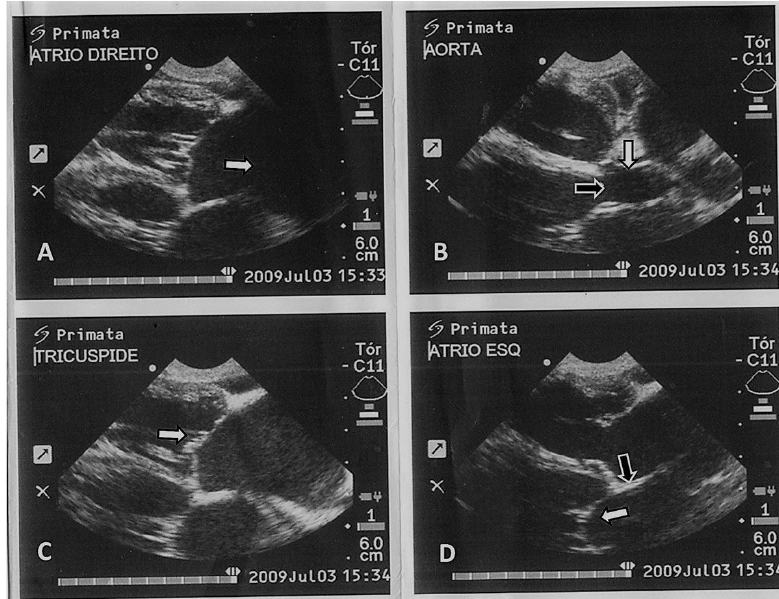
Figure 2. Echocardiographic examination. (A) Enhanced right atrium (filled arrow); (B) Aorta unchanged: preserved aortic valve (arrow outline) and intact aortic entry (filled arrow); (C) Discrete reflux in tricuspid, evaluated by Doppler (filled arrow); (D) Left atrium with overload and eccentric hypertrophy (arrow outline), mitral valve with discrete thickening (filled arrows). Results compared to established reference values for